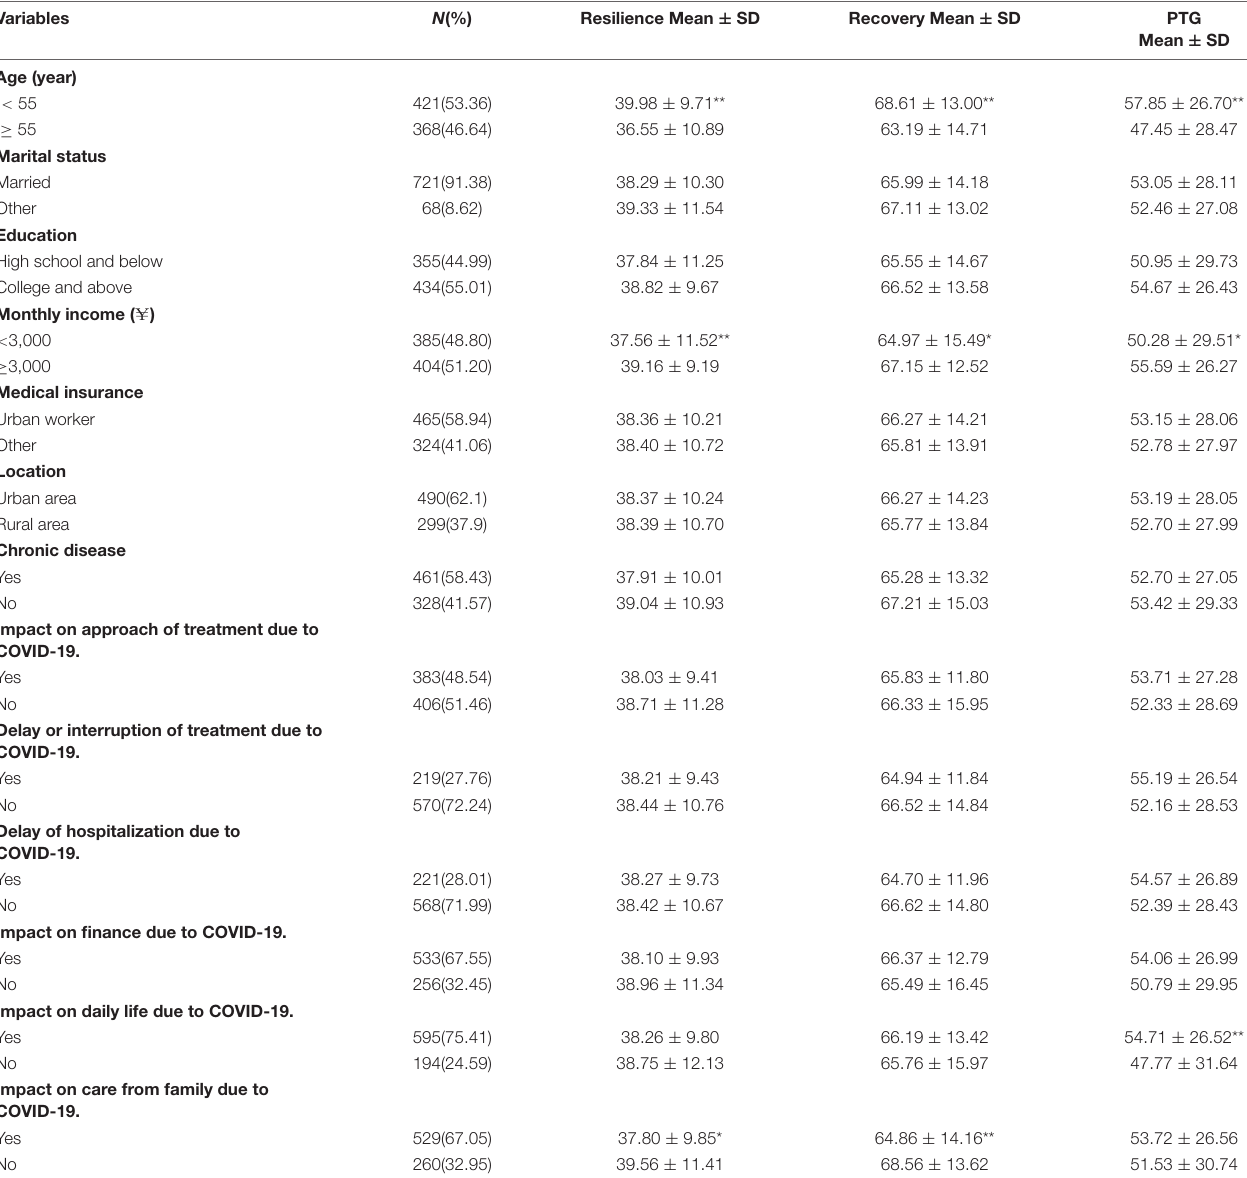
TABLE 1 | Demographic characteristics of patients with breast cancer and PTG